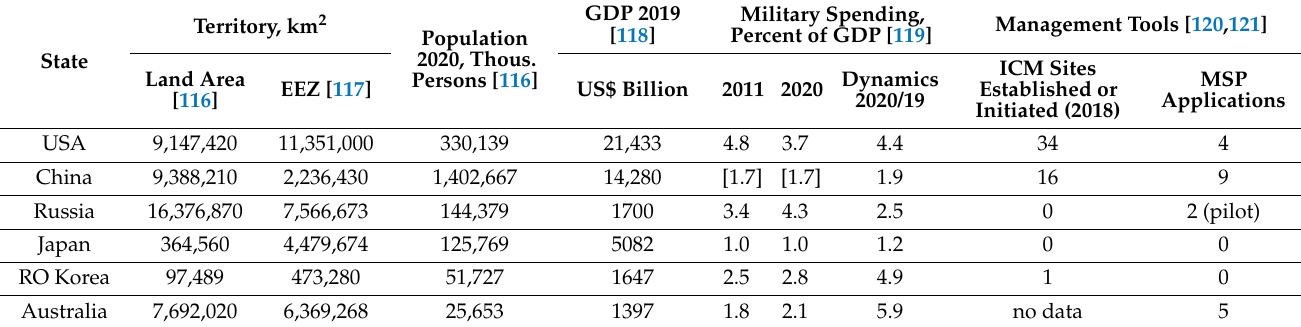
Table 2. Characteristics of the major maritime Powers of the Asia-Pacific